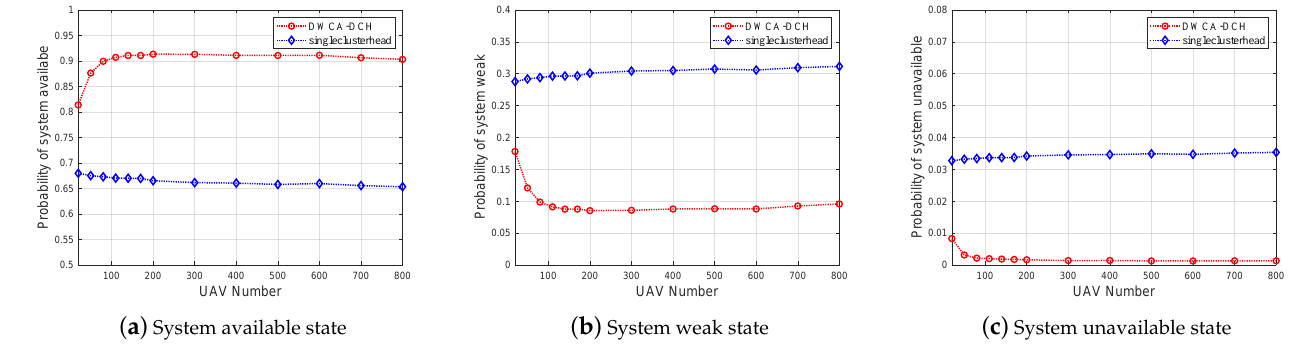
Figure 5. The probability of each state of the system with the increase in the number of UAVs. Table 3. Comparison of system available probability between DWCA-DCH and single cluster head algorithm.